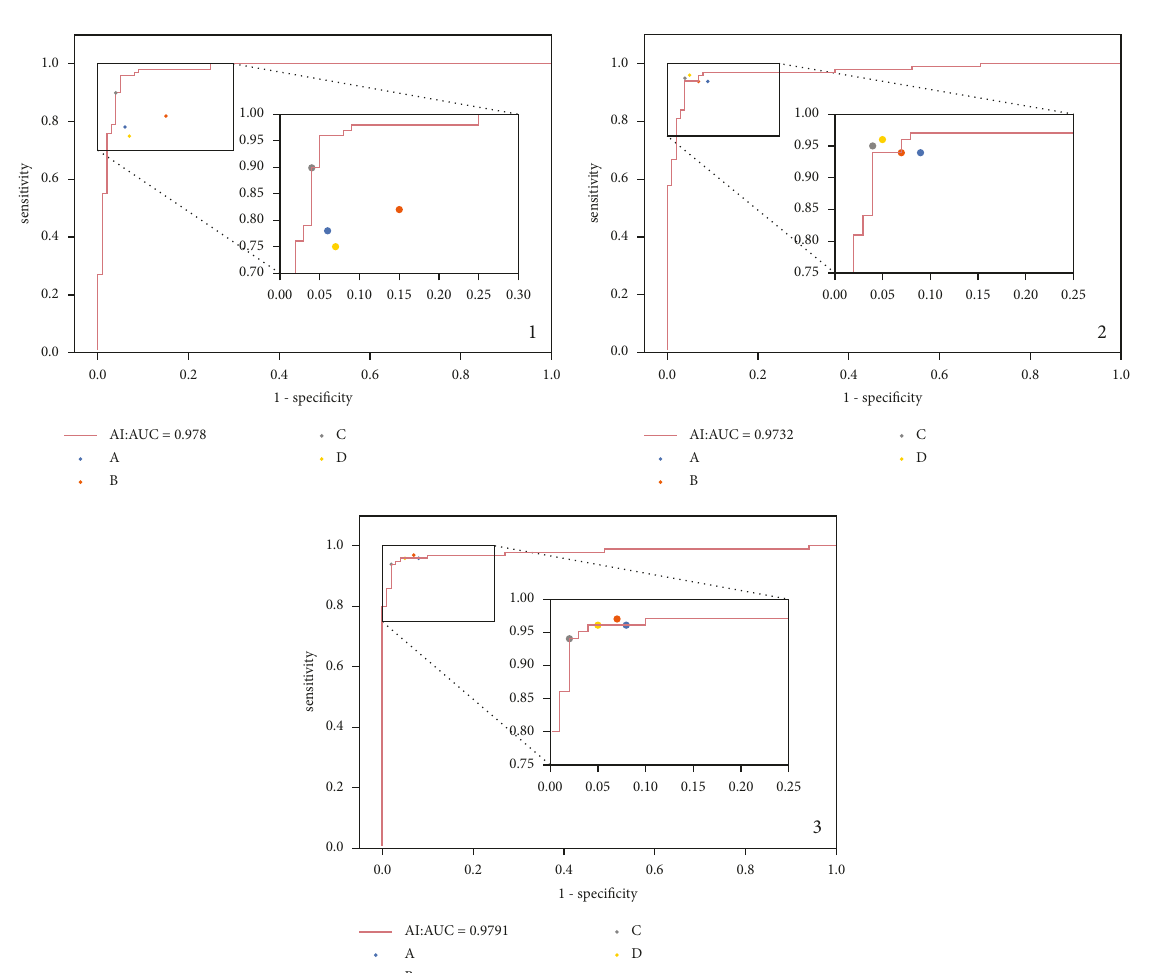
Figure 3: (a–c) The ROC curve of AI diagnosis and the sensitivity and specificity of four doctors’ diagnosis in the first, second, and third rounds. It can be seen from (a) that, in the first round, the AUC of AI diagnosis was 0.978. Among the four doctors, the diagnostic accuracy of doctor C was roughly equal to that of AI and the diagnostic accuracy of doctors A, B, and D was significantly lower than that of AI. In the second stage, the AUC of AI diagnosis was 0.973. Among the four doctors, the diagnostic accuracy of doctor C and doctor D was slightly higher than that of AI, the diagnostic accuracy of doctor B was roughly the same as that of AI, and the diagnostic accuracy of doctor A was slightly lower than that of AI. In the third round, the AUC of AI diagnosis was 0.979. Among the four doctors, the diagnostic accuracy of doctor B was slightly higher than that of AI, and the diagnostic accuracy of doctors A, C, and D was roughly the same as that of